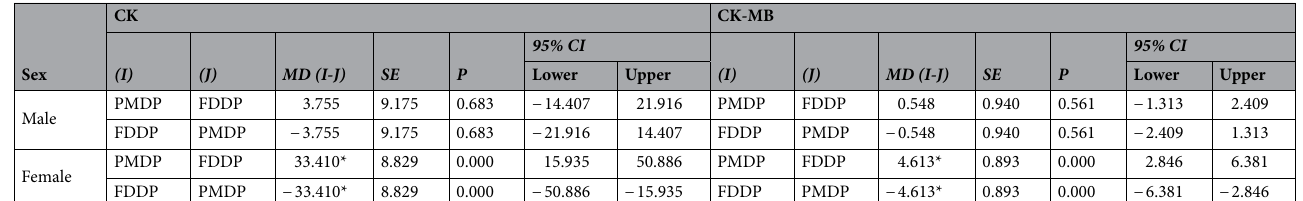
Table 6. Pairwise analysis of interactions. The dependent variables are CK and CK-MB. (I) PMDP = 1, FDDP = 2; (J) PMDP = 1, FDDP = 2. * P <